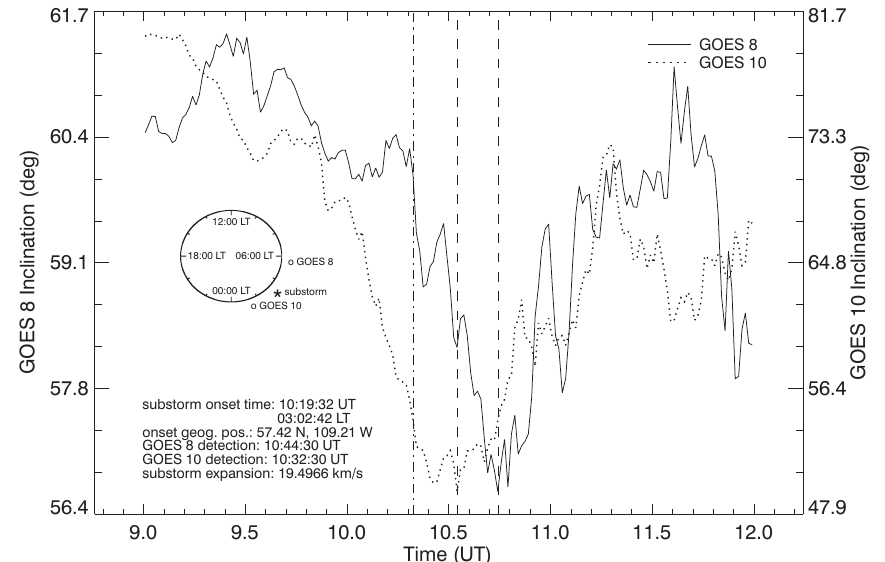
Fig. 4. Magnetic inclination calculated from GOES data showing dipolarization signatures of a substorm event on 20 February 2001.